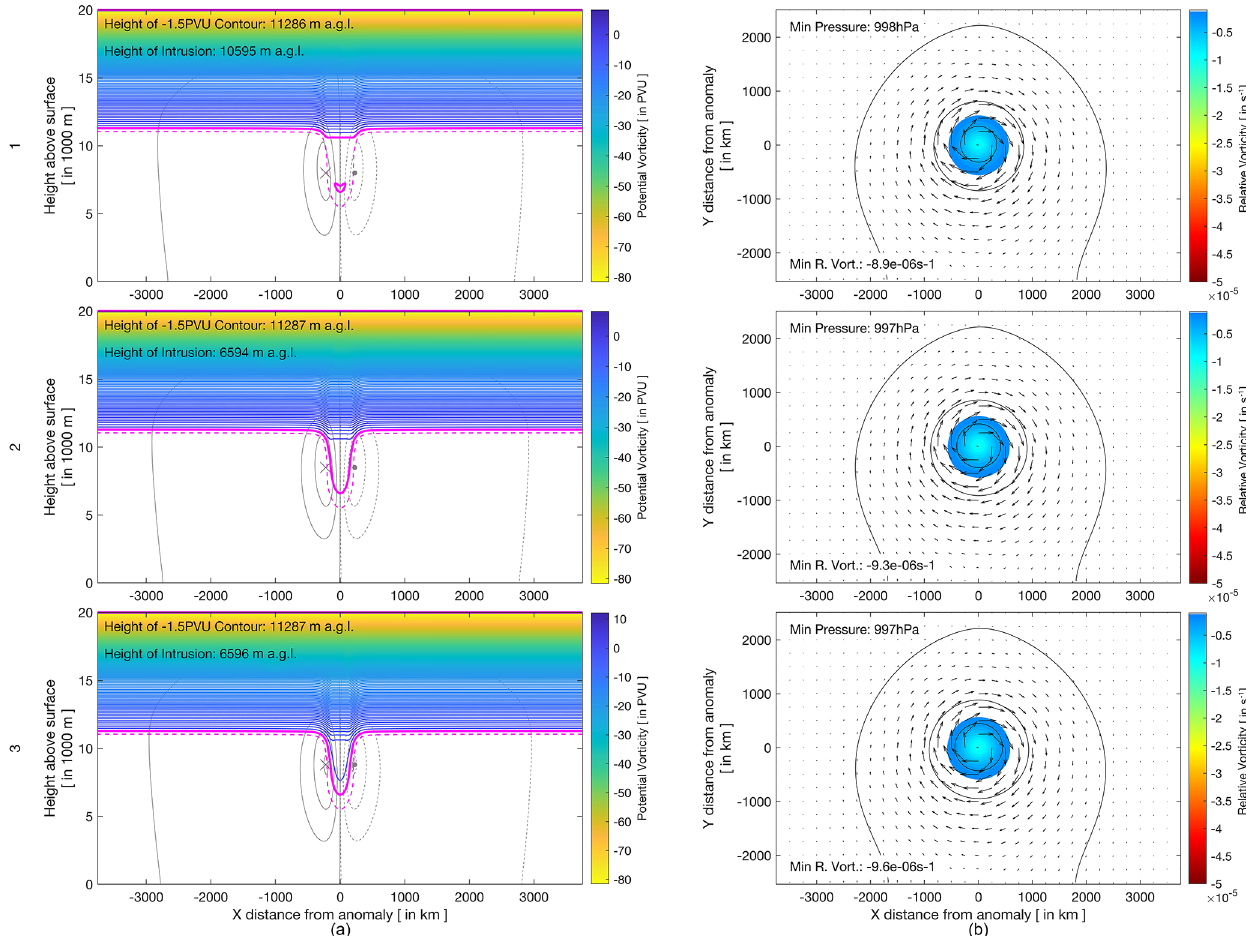
Figure 12. Same as in Experiment 0 with varying anomaly magnitudes of − 1.0PVU (row 1) and − 2.0PVU (row 3). Experiment 0 (with an anomaly magnitude of − 1.5PVU) is shown in row 2. In addition to the − 1.5PVU contour (thick magenta line), the − 1.0PVU contour is also provided for context by a dashed magenta line.